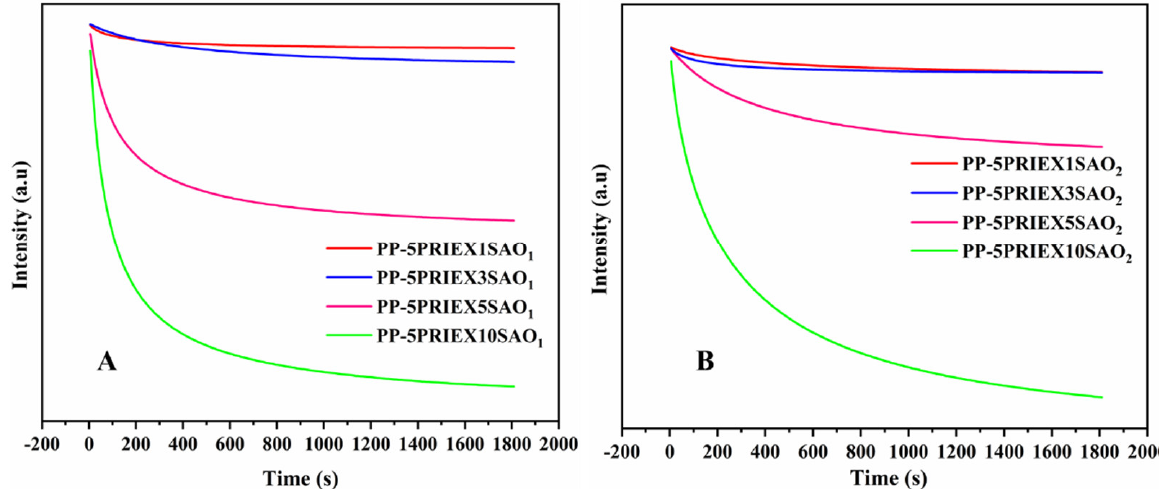
Figure 8. The phosphorescence intensity decay with time for PP/PRIEX/SAO 1 ( A ) and Figure PP/PRIEX/SAO 2 ( B ) composites .